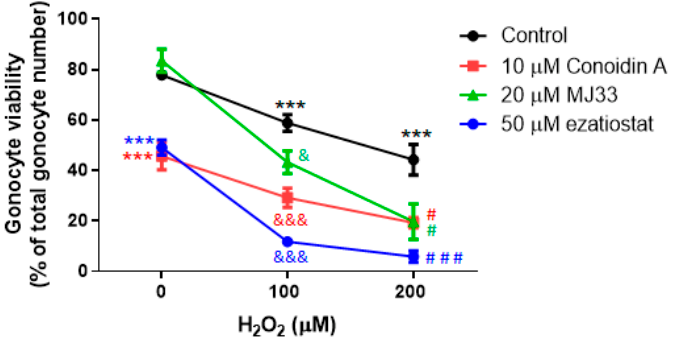
Figure 4. Effects of H 2 O 2 and PRDX inhibitors on PND3 gonocyte viability. H 2 O 2 and PRDX inhibitors were added to the cells at the indicated concentrations, alone or together for 2 h. Cell viability was determined by trypan blue exclusion method. Results represent the means ± SEM from at least three experiments. Statistical significance: *** p ≤ 0.001 treatment vs control; & p ≤ 0.05, &&& p ≤ 0.001 treatment vs 100 μ M H 2 O 2 ; # p ≤ 0.05, ### p ≤ 0.001 treatment vs 200 μ M H 2 O 2.